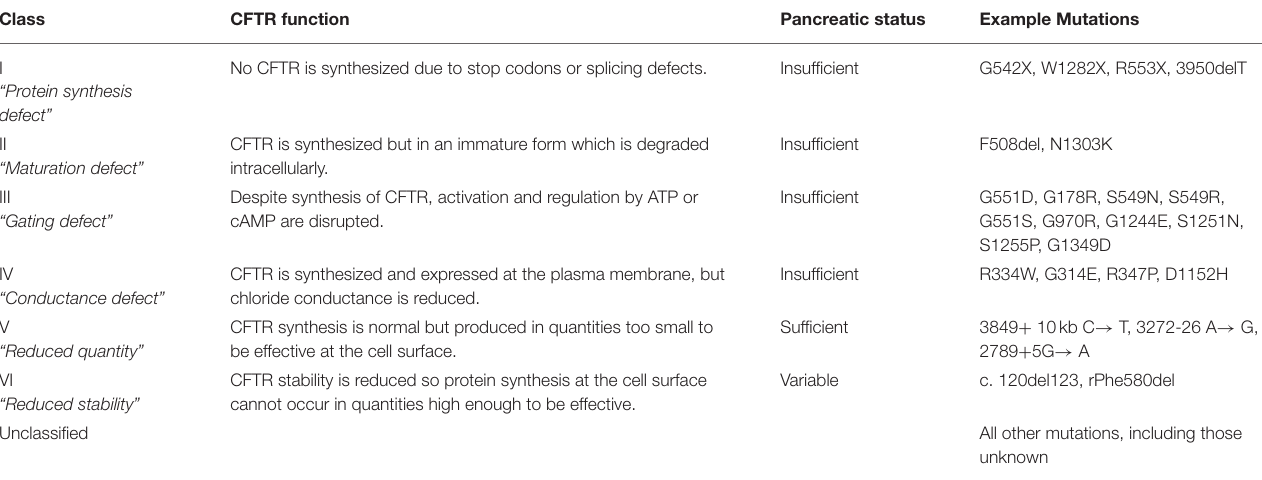
TABLE 1 | An overview of the genotype classes in CF, with their associated pancreatic phenotype (11–13). Class CFTR function Pancreatic status Example